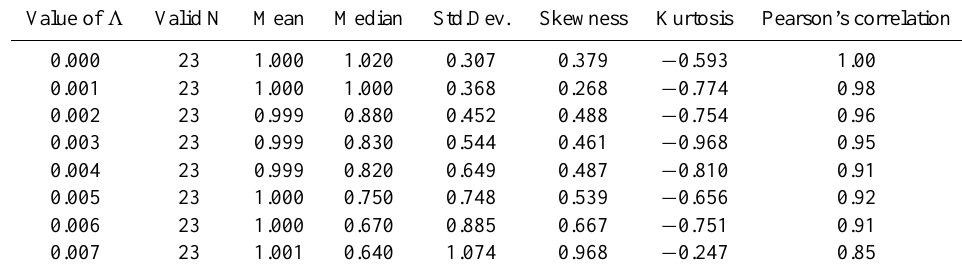
Table 2. Descriptive statistics of simulated tree-ring curves obtained by different values of drainage coefficient 3 . Last column is Pearson correlation between the initial chronology ( 3 =0) and the estimated curve using different values of drainage coefficients. Value of 3 Valid N Mean Median Std.Dev. Skewness Kurtosis Pearson’s correlation 0.000 23 1.000 1.020